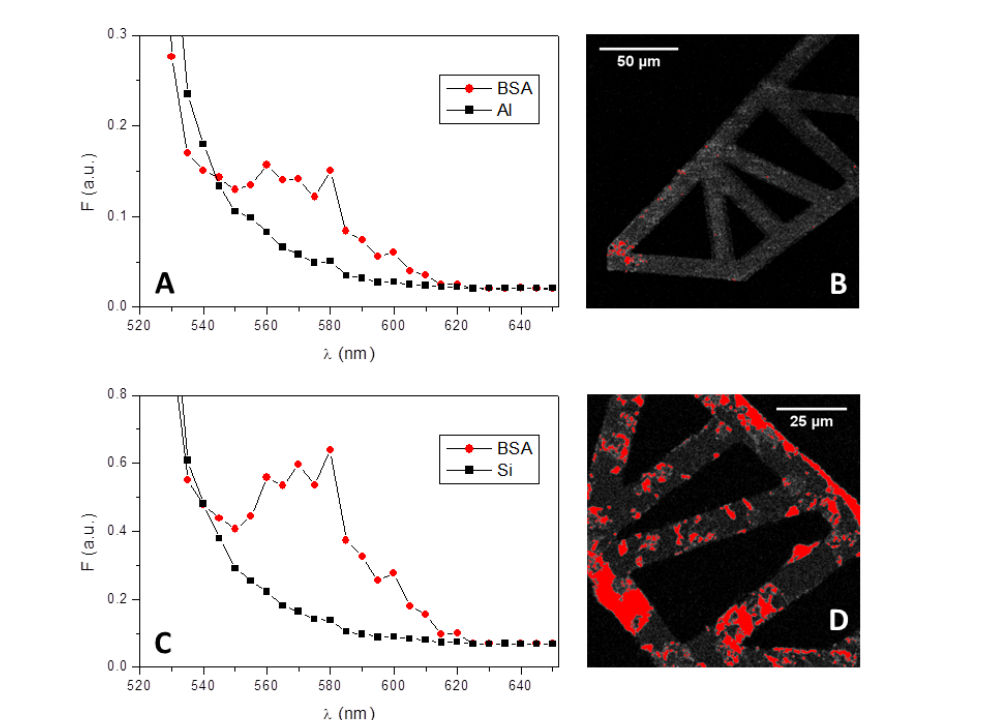
Figure 12. Fluorescence spectra and images of BSA-TAMRA adsorbed on the aluminum side ( A and B ) and on the silicon side ( C and D ) of microgrippers. In addition, 10 mg/mL of BSA-TAMRA were incubated at room temperature for 5 h separately on both microgrippers’ sides. Spectra were acquired where the fluorescence signal was higher (i.e., on the red areas, B and D ) and outside these areas but on microgrippers (gray structures, b and d ), giving, respectively, the red circles’ curves and the black squares’ curves of A and C .